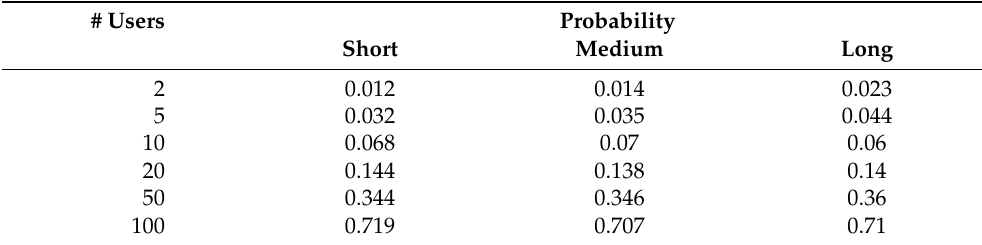
Table 2. Probability of quality downgrade events with variable number of users.